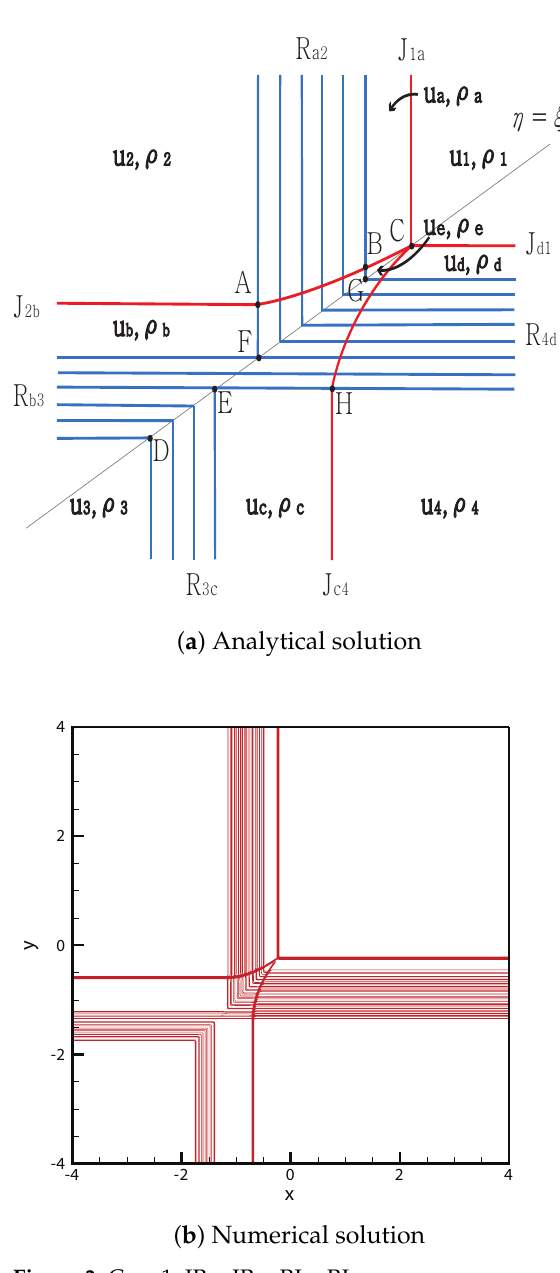
Figure 3. Case 1. JR + JR + RJ + RJ. Case 2. R + JR + R + JR ( u 3 < u 2 < 0 < u 4 < u 1 )